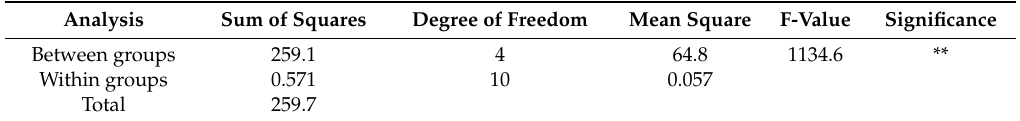
Table 10. One-way analysis of variance (ANOVA) for moisture stability.